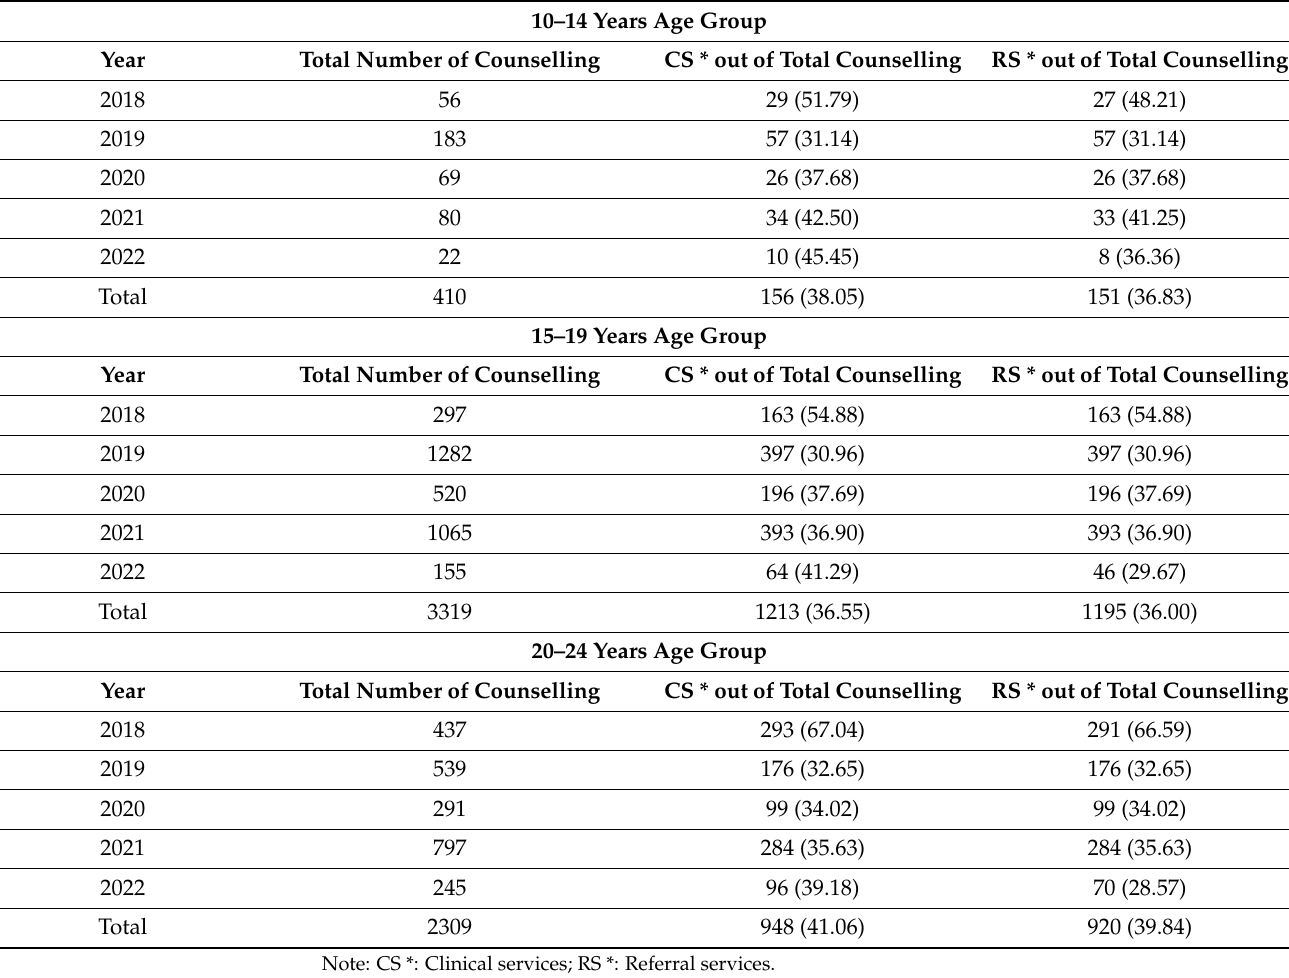
Table 4. Distribution of counselling, clinical, and referral of beneficiaries by year and age group.